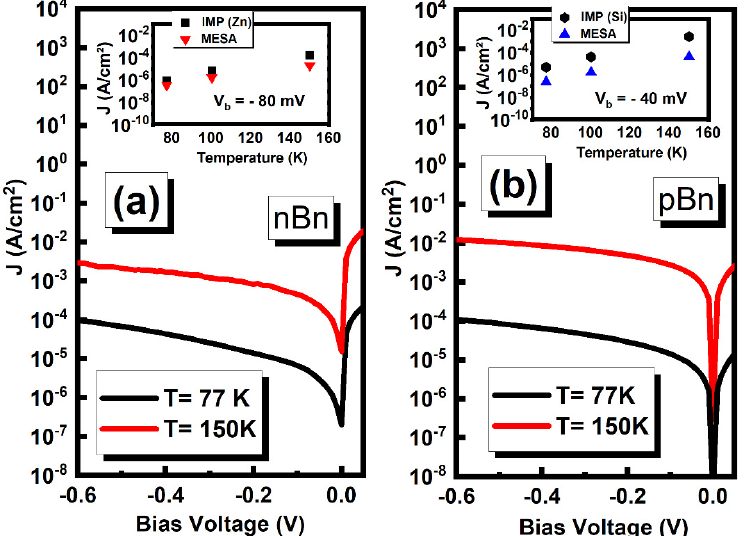
Figure 4. ( a ) Dark current density vs. applied bias voltage of the optimized ion-implantation condi- tion at 77K and 150 K for MWIR nBn ( a ) and pBn ( b ) planar devices. The inset of each part compares the dark current density values for planar and mesa-etched photodetectors at 77, 100, and 150 K. All diodes were circular with a 200-µm diameter. The comparison of the optical performance of both MWIR planar devices under op- timized implantation at 77 K and 150 k is shown in Figure 5a,b. The calculated saturated QE values of both devices were also compared with the mesa-isolated devices. For the optical test, the top illumination approach was chosen with no anti–refection coatings, and a calibrated 1000 °C blackbody source and Fourier transform infrared (FTIR) spectrometer were used. For the nBn and pBn planar devices, saturated QE values were calculated at − 80 mV and − 40 mV bias voltage, respectively. The 50% cut-off wavelength for the nBn planar device at 77 K, was 4.10 µm, with a saturated peak responsivity (R i ) of 0.67 A/W at λ = 3.35 µm at a − 80 mV applied bias. At 150 K, the saturated peak responsivity was 0.84 A/W at the same wavelength, with a 50% cut-off wavelength 4.40 µm. For the pBn device at 77 K and a − 40 mV bias voltage, the 50% cut-off wavelength of the planar device was 4.40 µm with a peak responsivity of 0.76 A/W at 3.8 µm. At 150 K, the peak responsivity increased to 1.09 A/W. The corresponding saturated QE values at peak responsivity for both planar devices are summarized in Table 2, along with relevant QE values for mesa- isolated devices. Table 2. Comparison of the QE values at peak responsivity for planar and mesa-isolated SLS devices at 77 and 150 K. (V b = − 40 mV for pBn and V b = − 80 mV for nBn ). Design